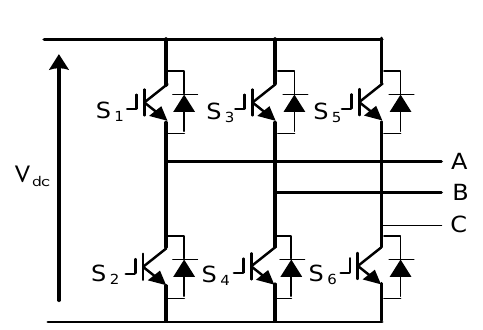
Figure 6: Three phase converter.